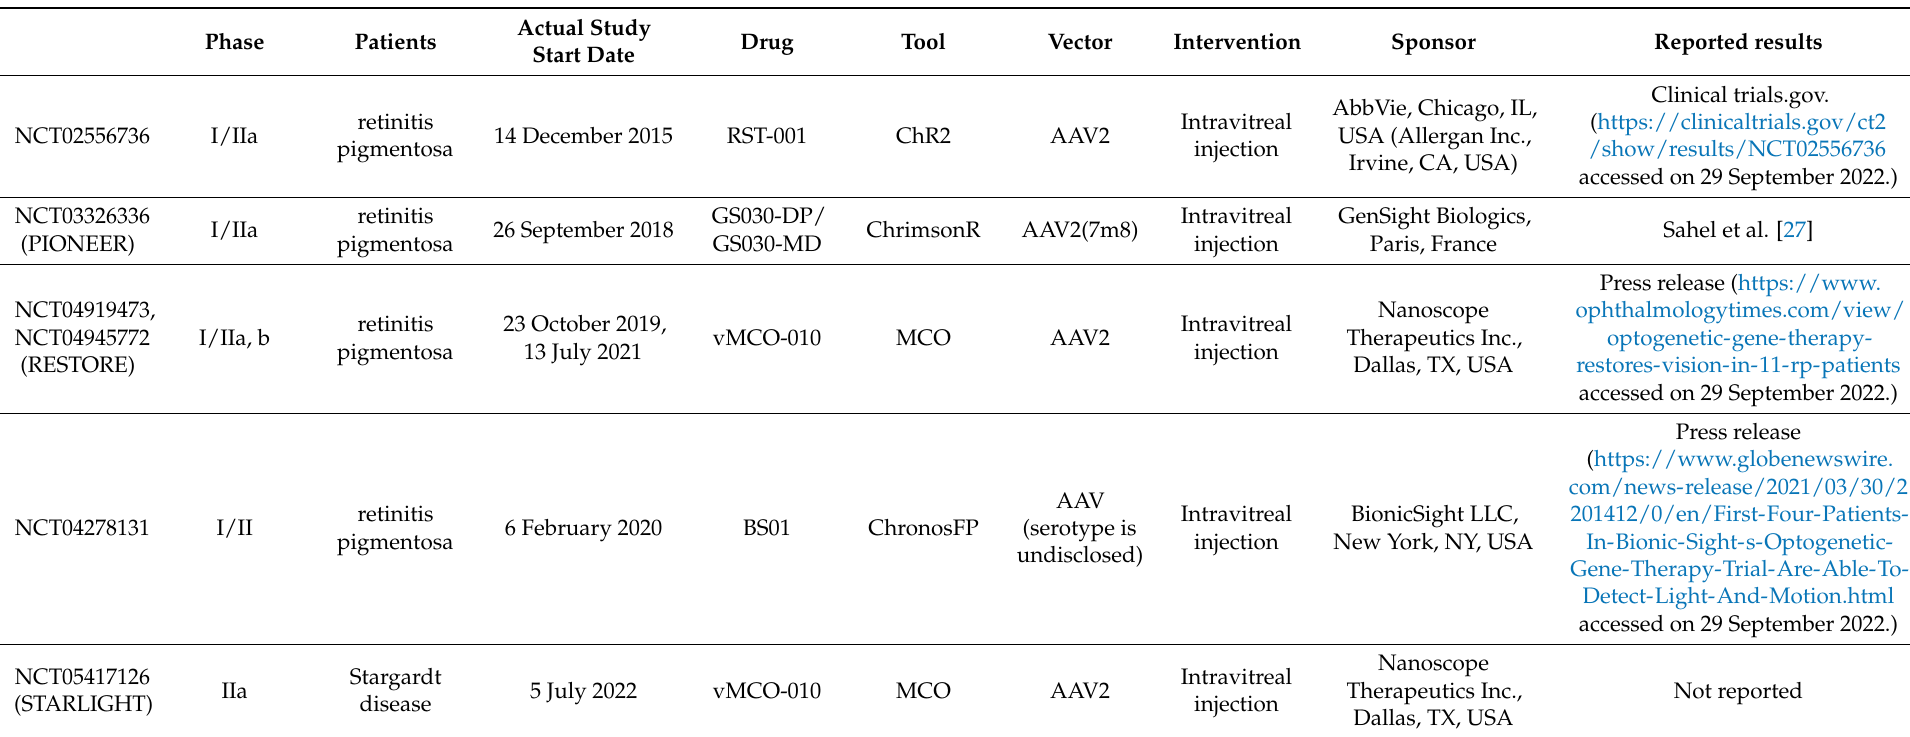
Table 2. Ongoing clinical trials of optogenetic